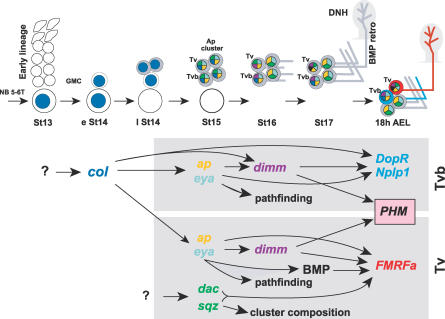
Model for the Thoracic NB 5–6 Lineage and for the Genetic Pathways Specifying Tv and Tvb NeuronsThe thoracic NB 5–6 lineage is shown at top, and the genetic pathways specifying Tv and Tvb neurons are at the bottom. NB 5–6 is formed already at late stage 8 and generates an early lineage of neurons (circles) and glia (uneven shape). For clarity, the early lineage is omitted from stage 14 and onward. The Ap cluster is generated between stages 13–15. The fate of the neuroblast itself is unclear after stage 15. Some of these regulatory interactions are occurring also in the non-peptidergic Ap cluster neurons, as well as in the dAp neurons, but for simplicity, they are not outlined here. See text for details.DNH, dorsal neurohemal organ; St, stage.